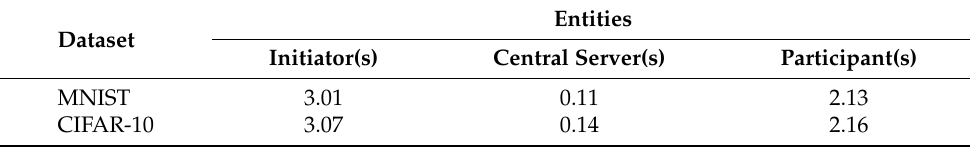
Table 2. Computation Overhead for Gradient